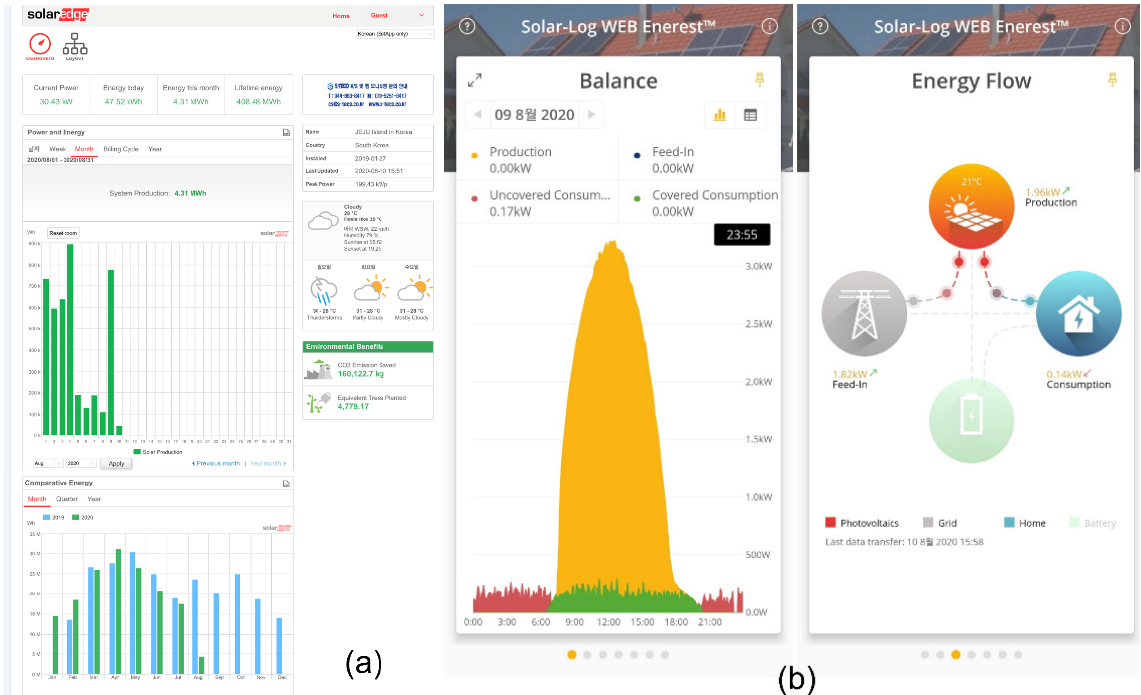
Figure 6. Representative smartphone applications for monitoring and control of PV systems: ( a ) PV system monitoring and logging (SolarEdge Monitoring app), and ( b ) energy flow (Solar-Log WEB Enerest™ app).